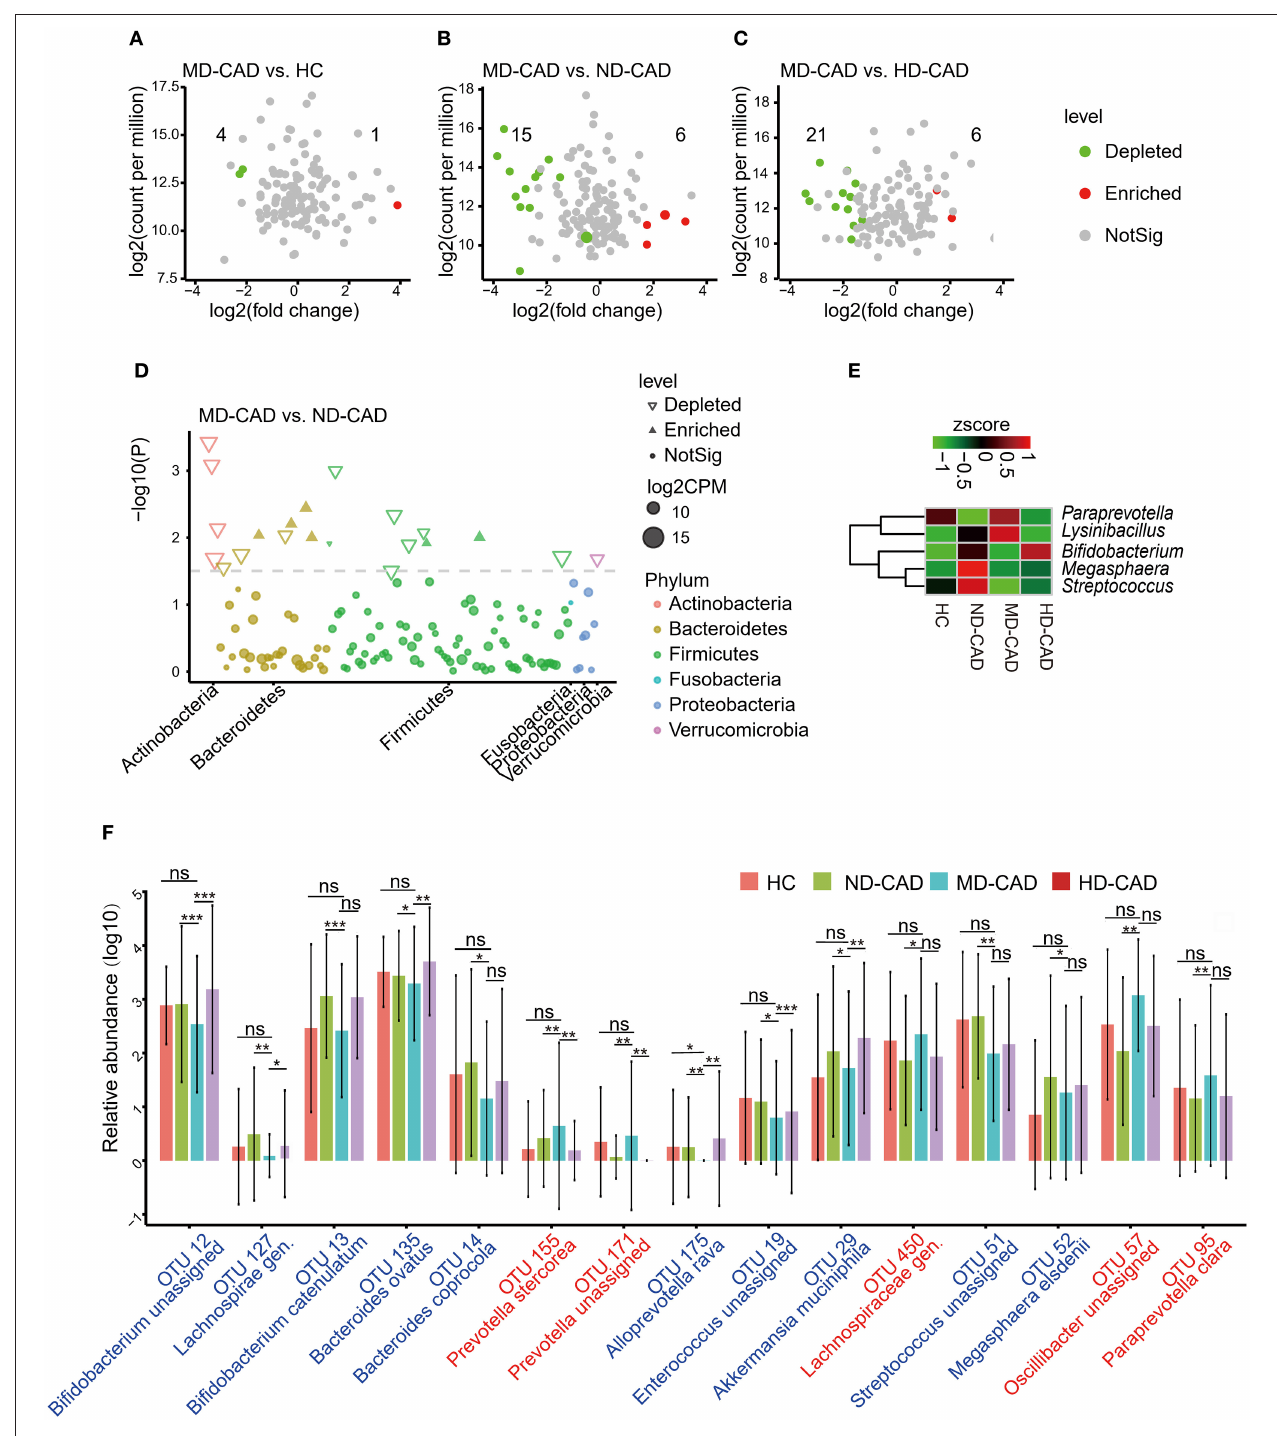
FIGURE 4 | Moderate alcohol consumption was associated with certain changes of intestinal flora in patients with CAD. (A–C) Volcano plots showing differential OTUs in patients with CAD with different levels of alcohol consumption. (A) MD-CAD vs. HC. (B) MD-CAD vs. ND-CAD. (C) MD-CAD vs. HD-CAD. The numbers labeled in the figures indicated significantly depleted OTUs (highlighted in green) or enriched OTUs (highlighted in red) in MD-CAD when compared with HC, ND-CAD, and HD-CAD, respectively. (D) Manhattan plot demonstrating the differentially abundant OTUs and their contributions to each phylum. (E) Heatmap showing the relative abundance of the genera that were significantly different between MD-CAD and ND-CAD. (F) An overview of the relative abundance of the differential OTUs associated with moderate alcohol consumption. The differential OTUs were filtered with P < 0.05 as well as FDR < 0.2. ns, not significant. * P < 0.05 and FDR < 0.2, ** P < 0.01 and FDR < 0.2, *** P < 0.001 and FDR < 0.2, analyzed by